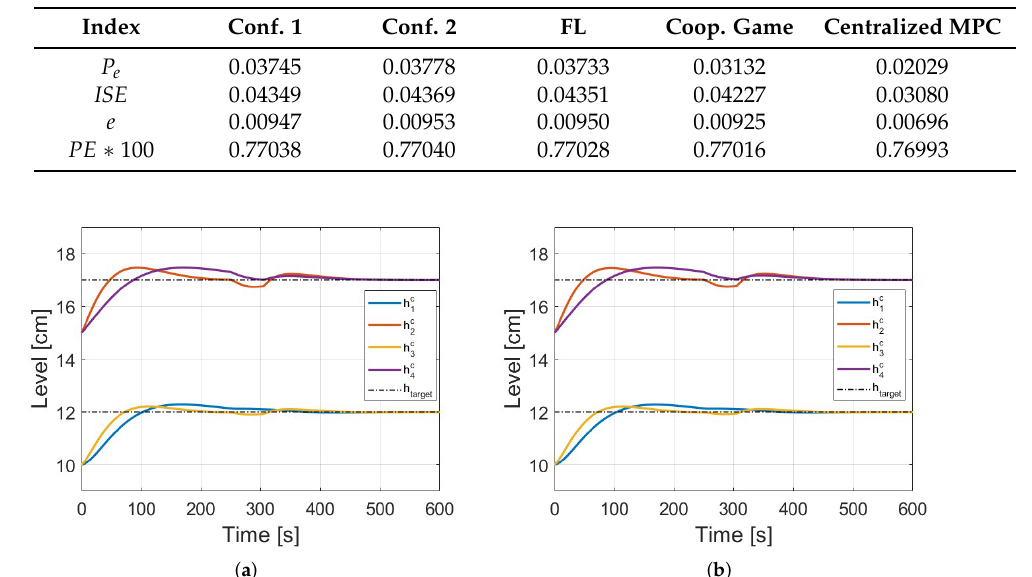
Table 4. Case 2: Configurations performance through performance indices value.